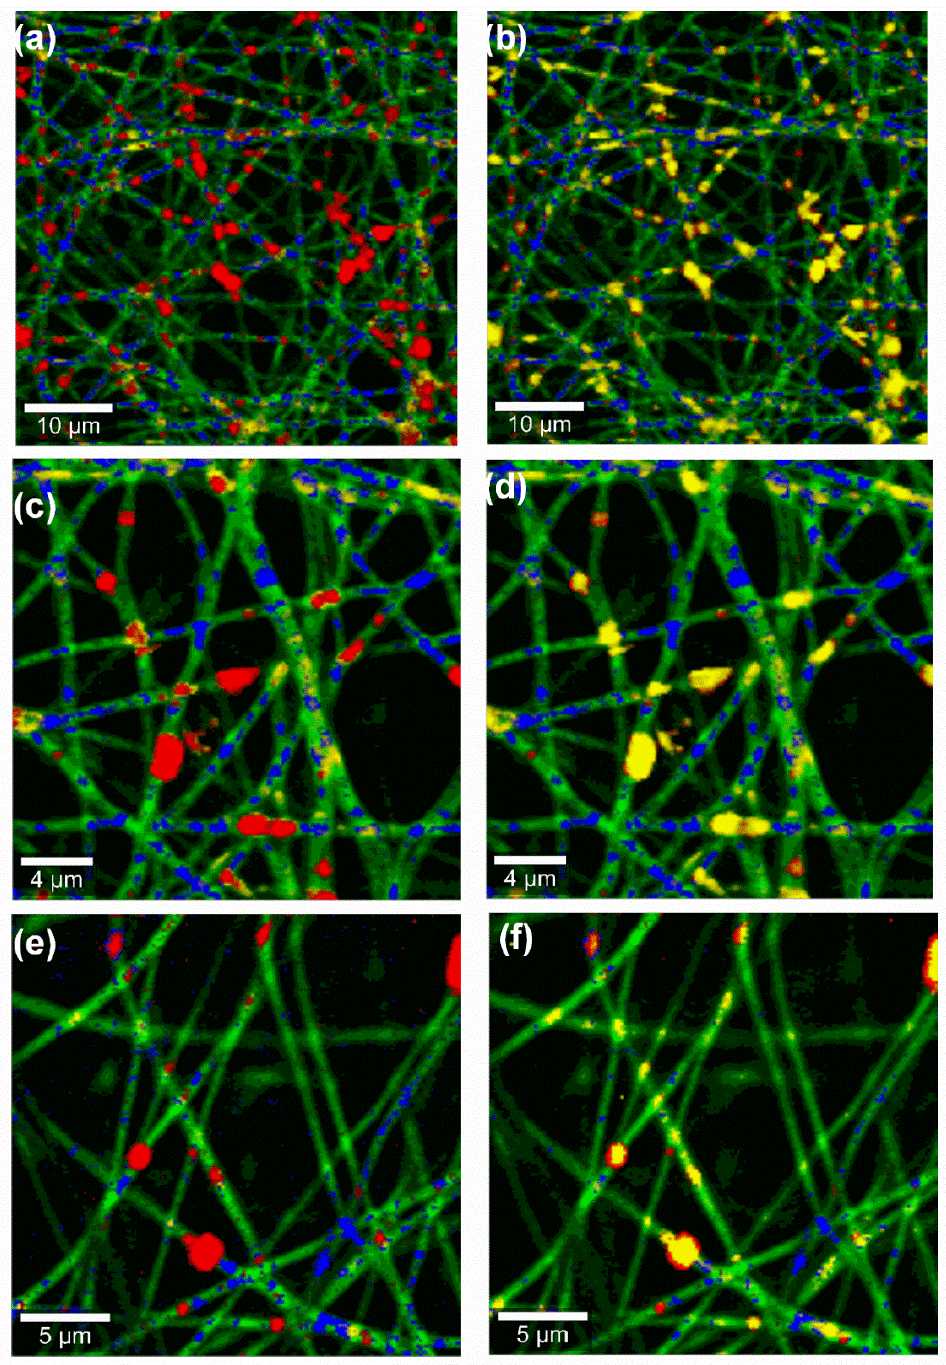
Figure 4. Confocal Raman microscopic color-coded images of TE-loaded fiber mats from ( a – d ) F3 ( e ), and ( f ) F2, Color code: Red: TE, Blue: PL90H, Green: PVA, Yellow: Sunflower oil; stack order of color code left column: green, yellow, blue, red; stack order of color code right column: green, red, blue, yellow.